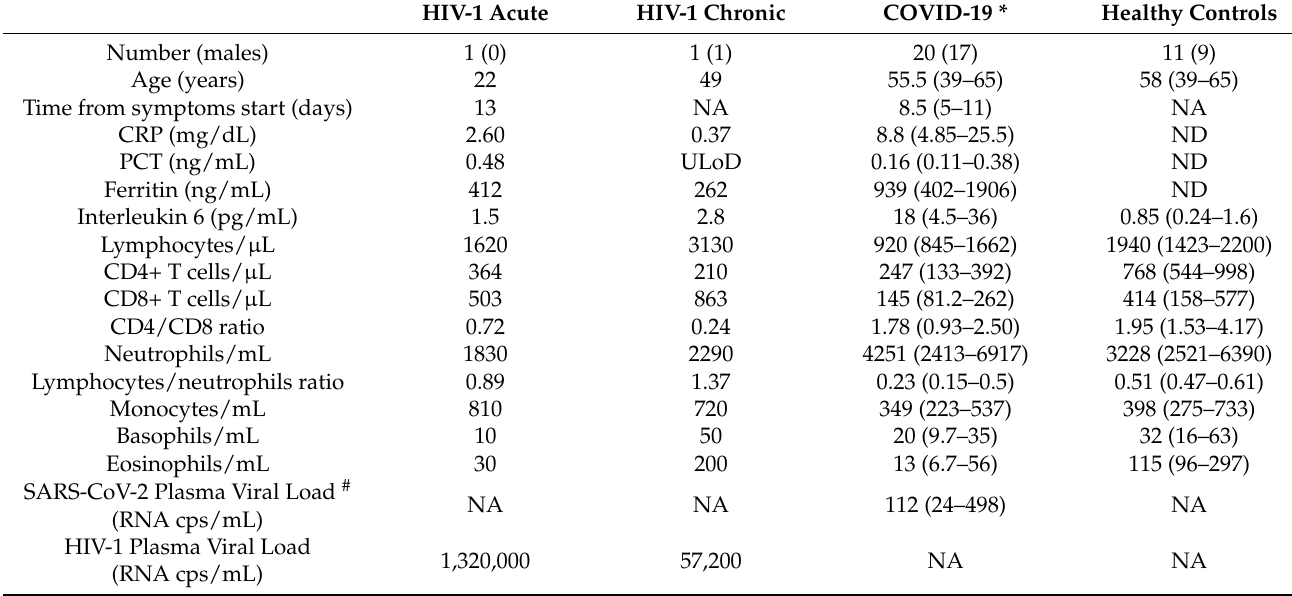
Table 1. Clinical and routine laboratory data from patients and healthy